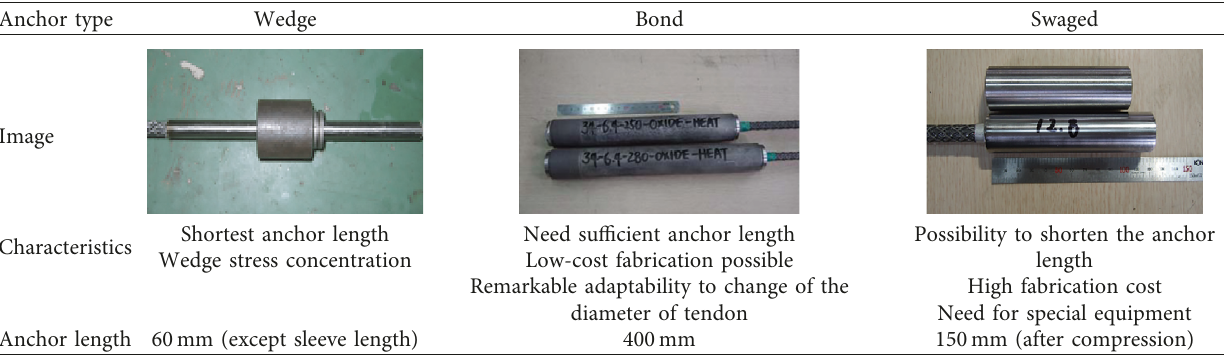
Table 3: Types of anchor for CFRP tendon.